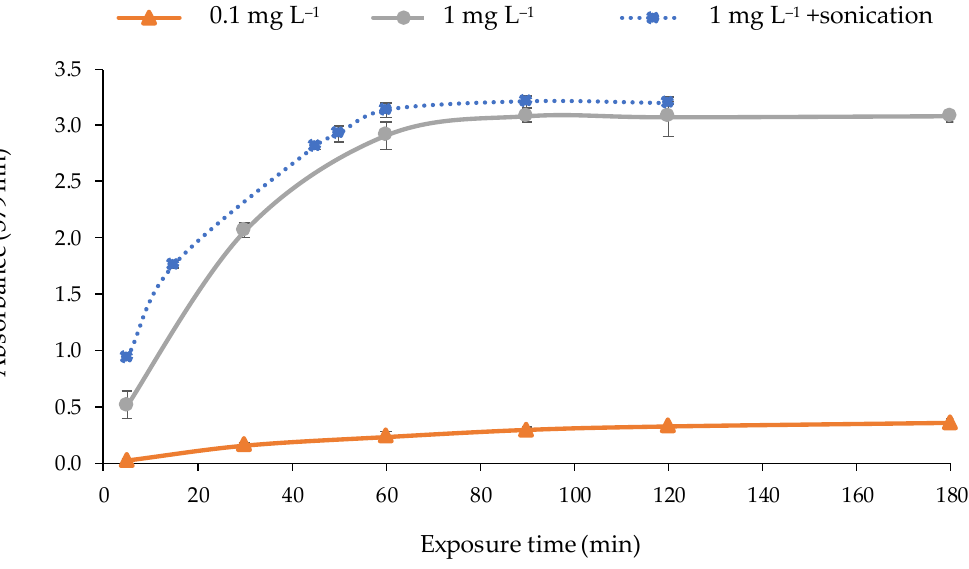
Figure 7. Response time of the optical sensor for different concentrations of Cd(II) (pH 9.5; 0.337 mol L − 1 buffer; n = 2) exposed to: shaking ( ⎯ ); shaking + sonication (2 min) (·····).